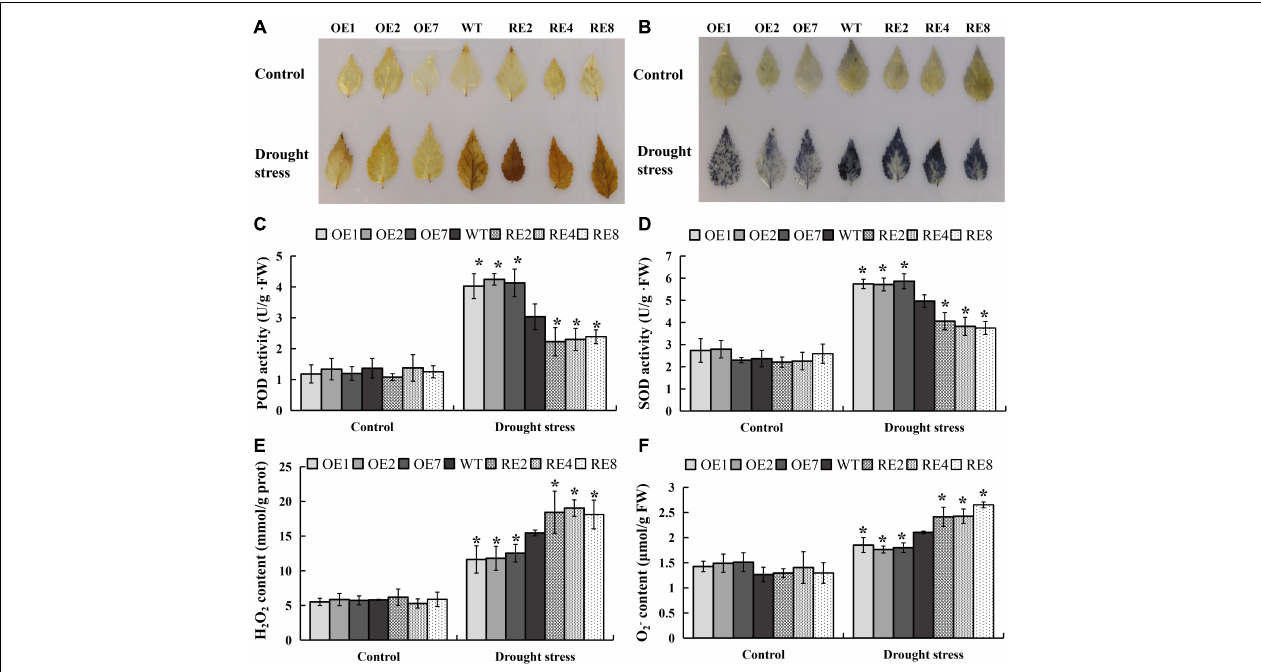
FIGURE 3 | Reactive oxygen species (ROS) scavenging analyses in BpMYB123 -overexpression ( BpMYB123-OE ) and BpMYB123 -repression ( BpMYB123 -RE) transgenic lines and wild-type. (A) Content of hydrogen peroxide (H 2 O 2 ) of BpMYB123 different lines under drought stress by 3,3 (cid:48) -diaminobenzidine (DAB) staining. (B) Content of superoxide radicals (O 2 − ) of BpMYB123 different lines under drought stress by nitroblue tetrazolium (NBT) staining. (C) Content of peroxidase (POD). (D) Content of superoxide dismatase (SOD). (E) Content of H 2 O 2 . (F) Content of O 2 − . Asterisks indicate significant differences by t -test, p < 0.05.